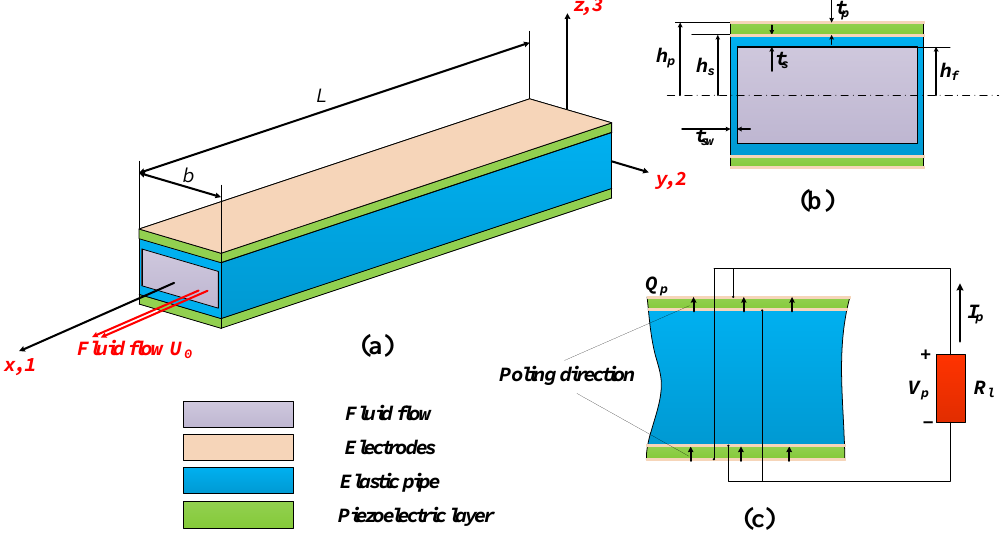
Figure 1. Schematic diagram of the proposed piezoelectric energy harvester based on the flow induced vibration of fluid conveying piezoelectric composite pipe: ( a ) whole view of the system, ( b ) the cross section view of the proposed energy harvester and ( c ) the externally connected circuits.